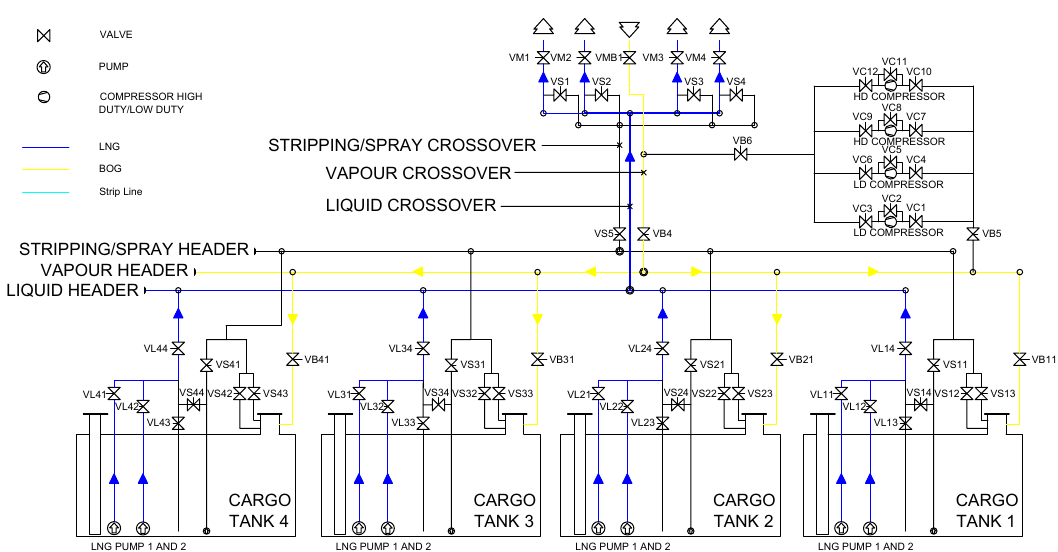
Figure A1. A schematic of the LNGC components used during discharging (authors’ illustration based on relevant technical manuals).